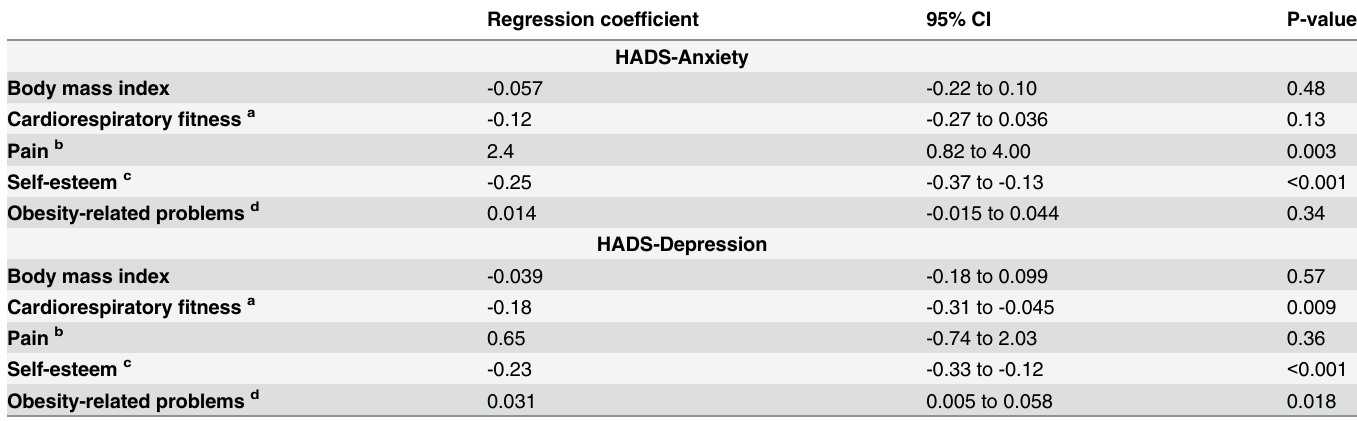
Table 4. Multivariable regression analysis of factors independently associated with Hospital Anxiety and Depression Scale (HADS) in n = 165 treat- ment-seeking young adults (16 – 25 y) with